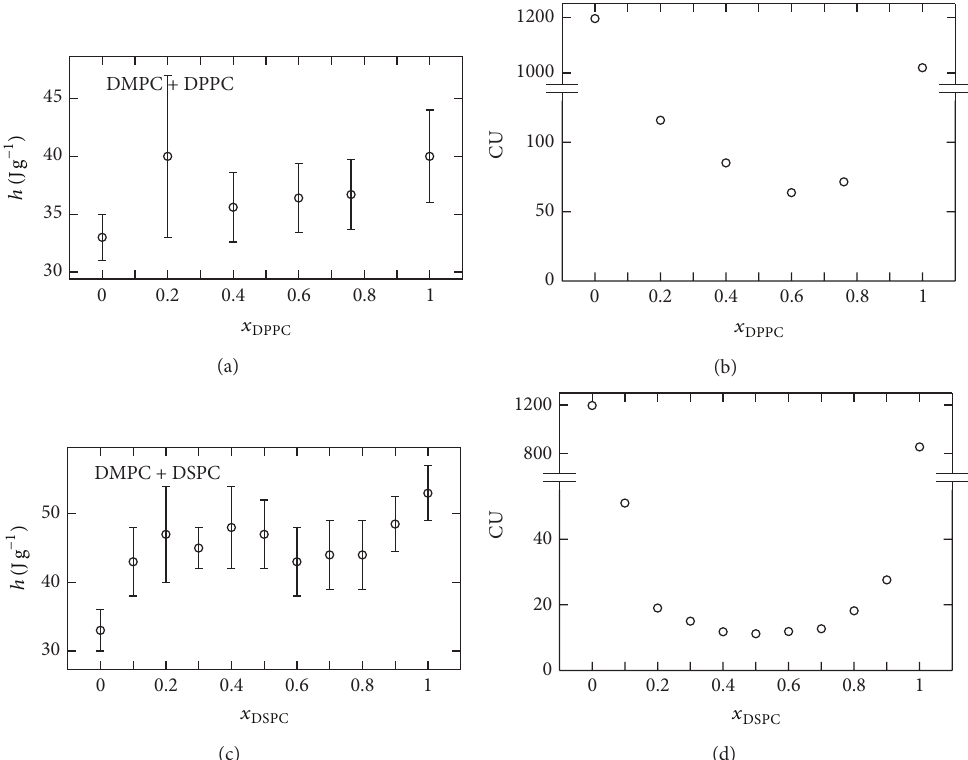
Figure 7: Transition heat and CU (Equations (3) and (4)) results for the lipid mixtures. (a) Total heat Δℎ and (b) cooperative unit CU for DMPC + DPPC; (c) Δℎ and (d) CU for DMPC + DSPC.